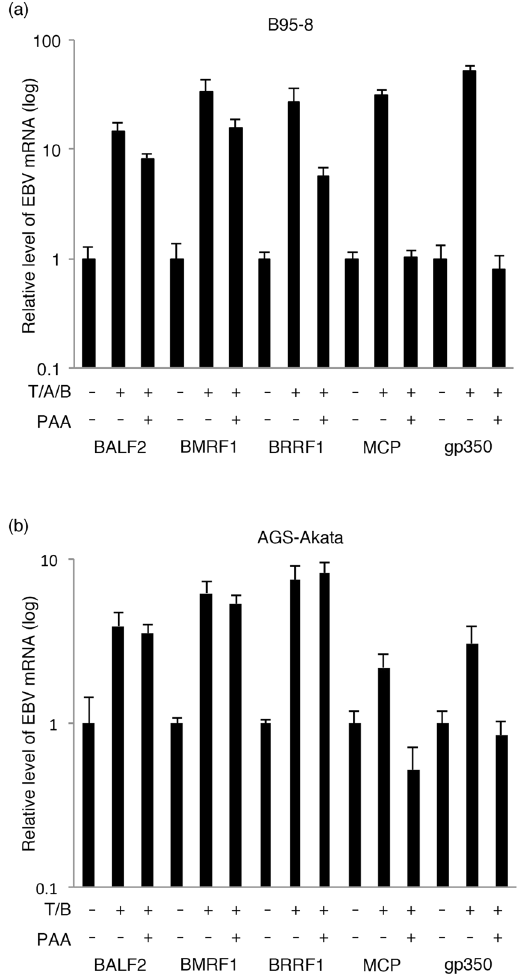
Figure 1. BRRF1 is expressed with early kinetics. ( a ) B95-8 cells were lytically induced by TPA, A23187 and butyrate (T/A/B) with or without PAA 14 . ( b ) AGS-Akata cells were lytically induced by TPA and butyrate (T/B) with or without PAA. Cellular RNA was collected after 48 hours, and qRT-PCR was performed using BALF2, BMRF1, BRRF1, MCP, gp350 and GAPDH primers. Relative mRNA levels for each gene are shown after normalization to GAPDH mRNA levels. Each bar represents the mean and standard deviation of three independent